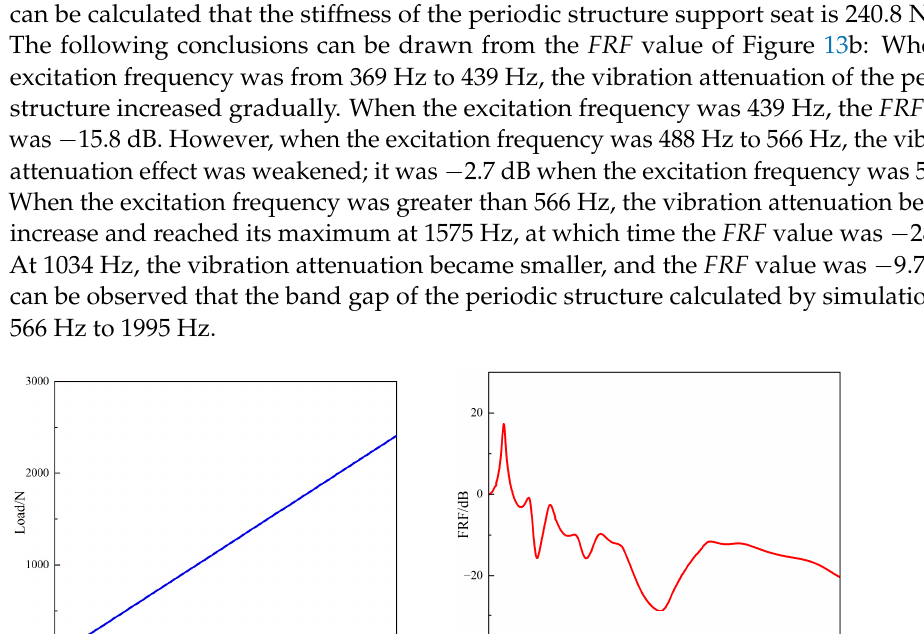
( b ) Figure 14. The response curves of the straight-tube structure support ( a ) Time domain input signal of straight-tube structure support, ( b ) time domain output signal of straight-tube structure support. The time domain responses of the input and output signals of the periodic structure support are shown in Figure 15. ( a )